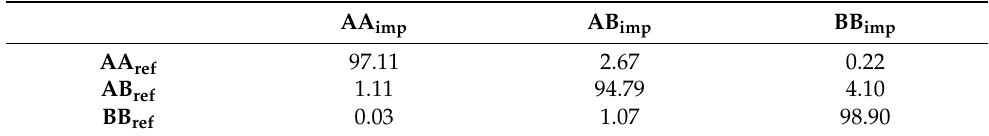
Table 7. Concordance rate in percentage between imputed and real genotypes of 136 target animals with a reference panel of 9596 purebred Hanwoo that were previously imputed from 50K to sequence.